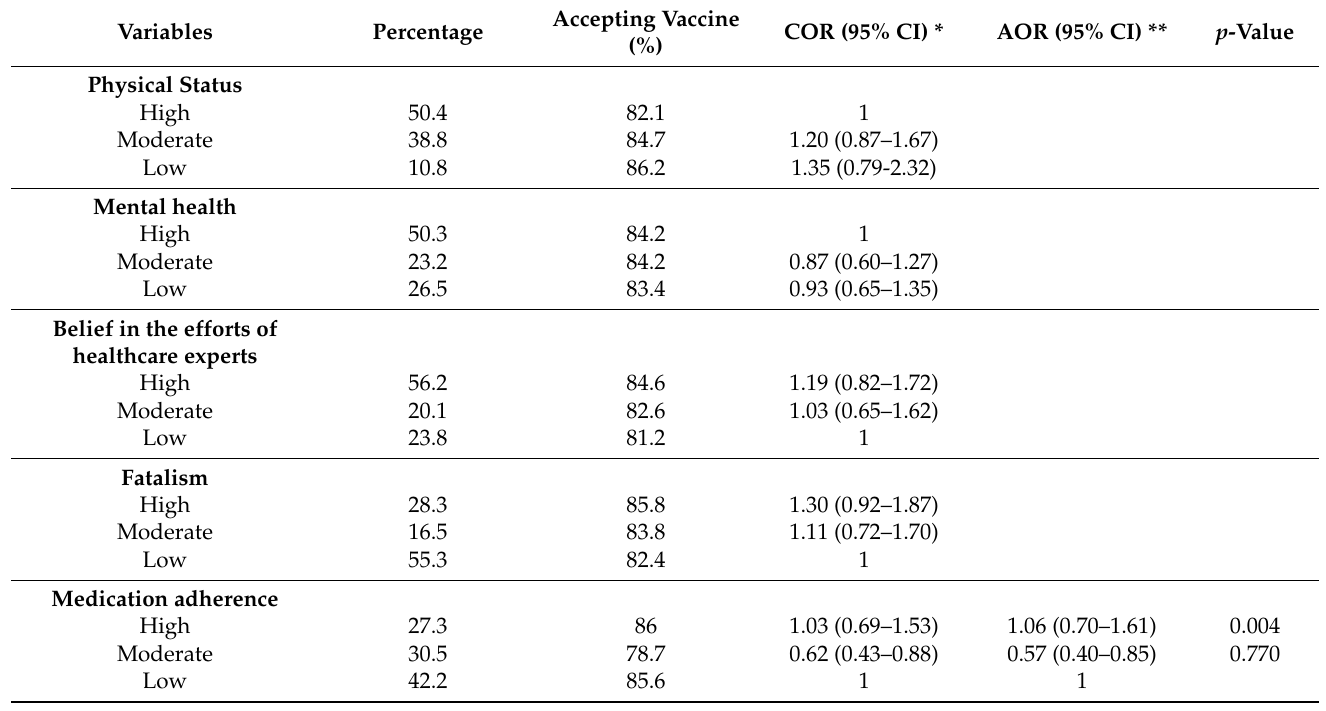
Table 3. Willingness to Receive COVID-19 Vaccine Based on Biopsychological Health Status, Believe in the Efforts of Medical Staff, Fatalism, Drug Adherence, Attitude to Government Performance, and the Results of Simple and Multiple Logistic Regression